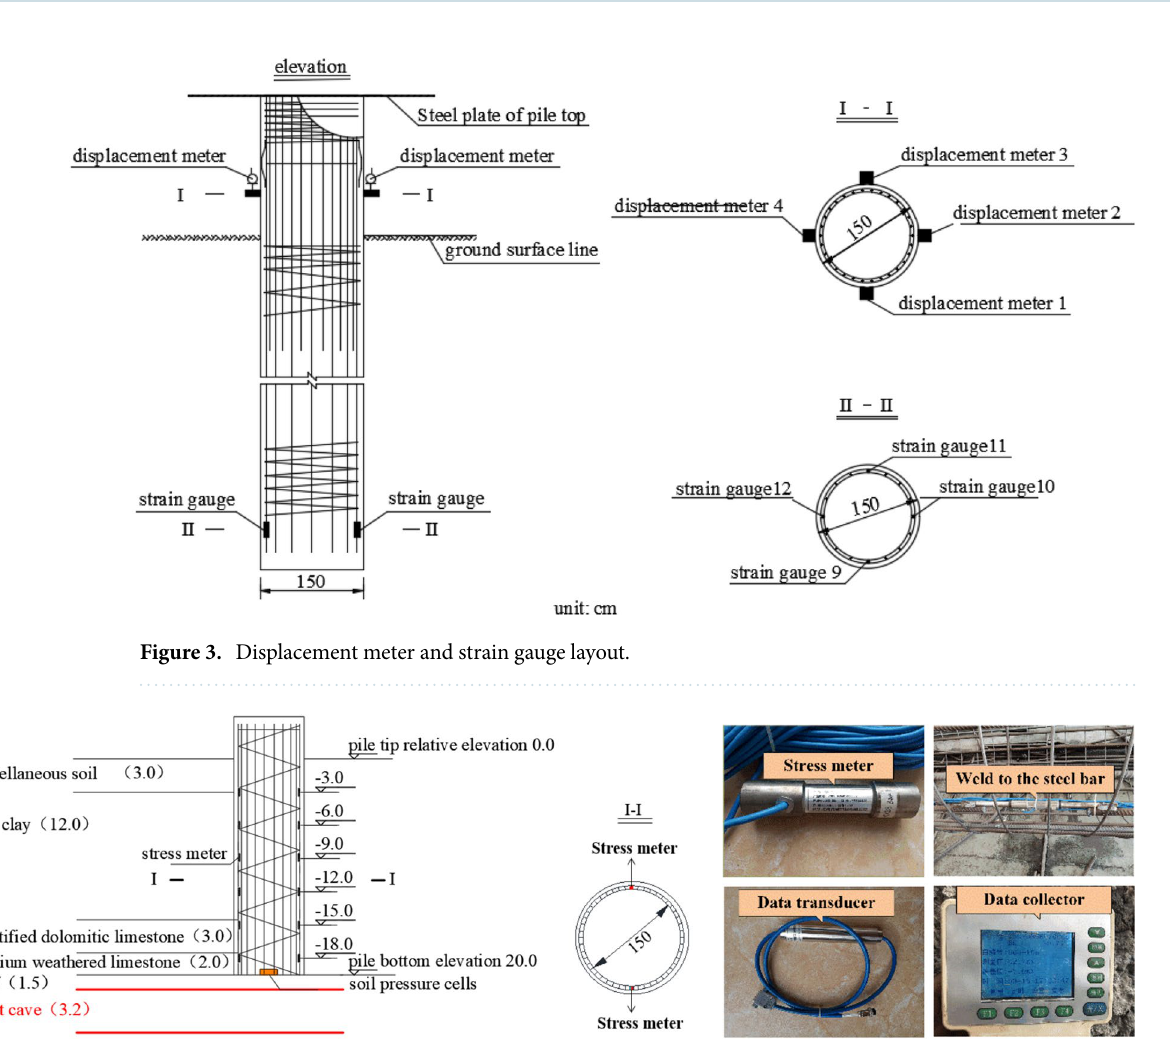
Figure 4. Arrangement of stress gauges and earth pressure